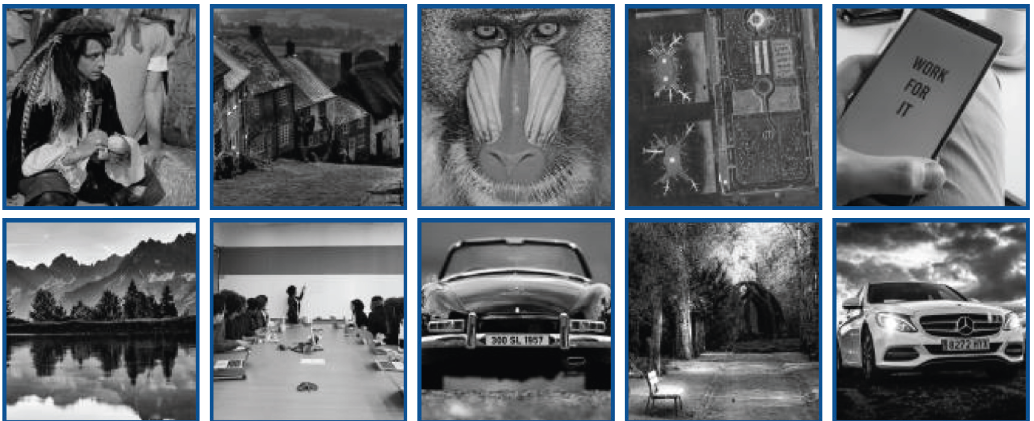
Figure 8: Thumbnails of used images.